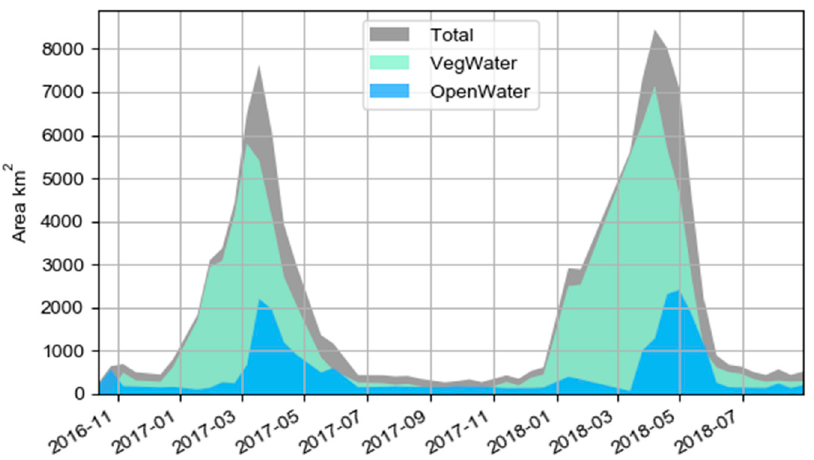
Figure 12. Water body extent derived from classified Sentinel-1 images for Barotseland over the study period.